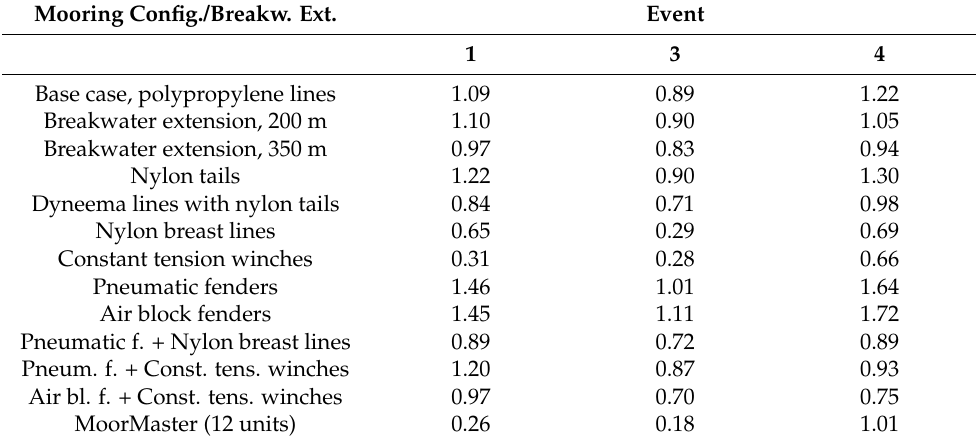
Table 8. Maximum sway motions (m).